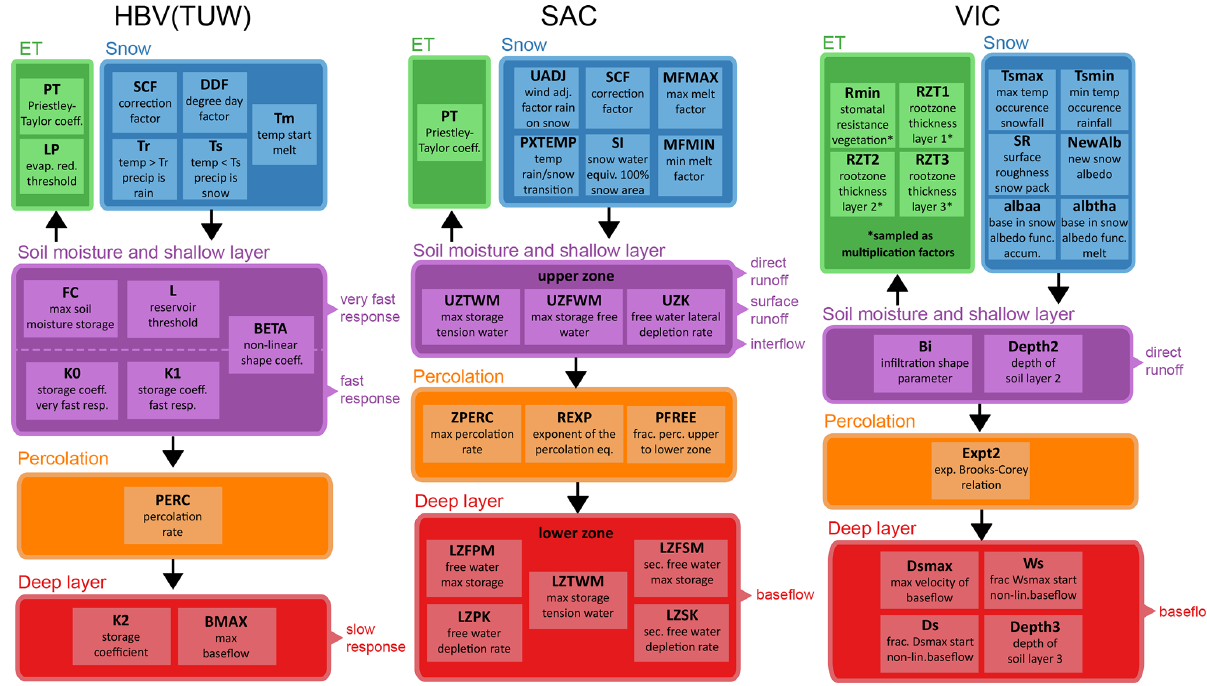
Figure 2. Simplified representation of the model structure of the three models employed in this study. All the parameters that are displayed are included in the sensitivity analysis. Parameters are coloured according to the flux or state they influence (evapotranspiration (ET), snow, soil moisture and shallow layer, percolation, deep layer). The colours are used consistently throughout all the figures in this study. Parameter boundaries can be found in Appendix Tables A1, A2, and